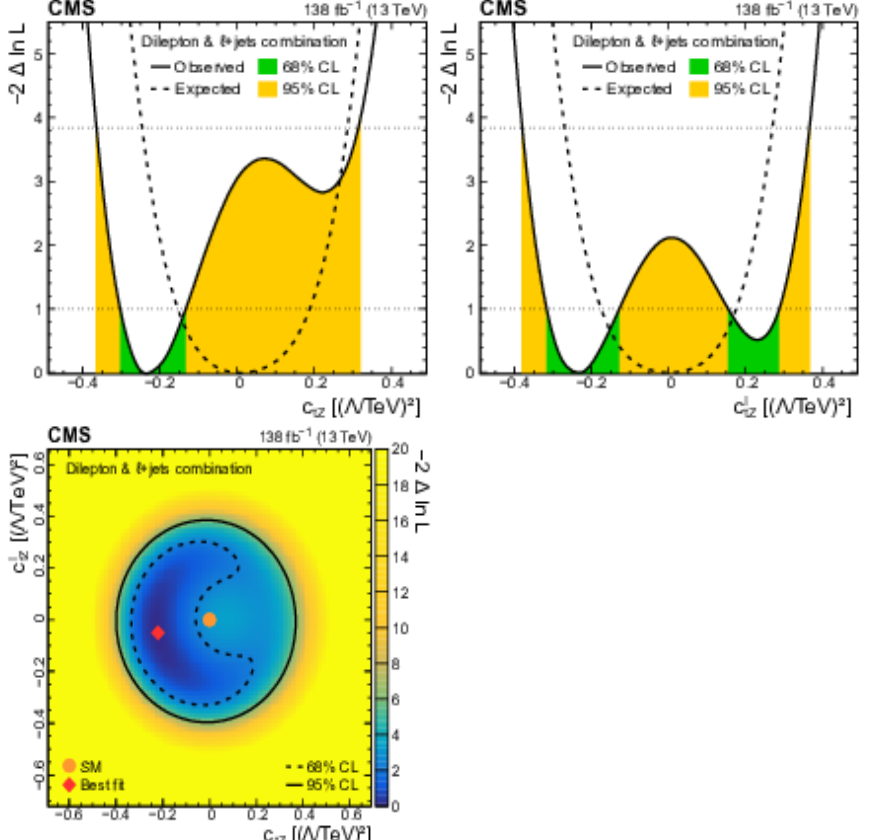
Figure 25. Distributions of the observed (solid line) and expected (dashed line) negative log-likelihood difference from the best fit value for the one-dimensional and two-dimensional scans of the studied Wilson coefficients. The results are obtained from the fit to data using the photon p T distribution. The plots shown here are from the combination of the single lepton and dilepton analyses